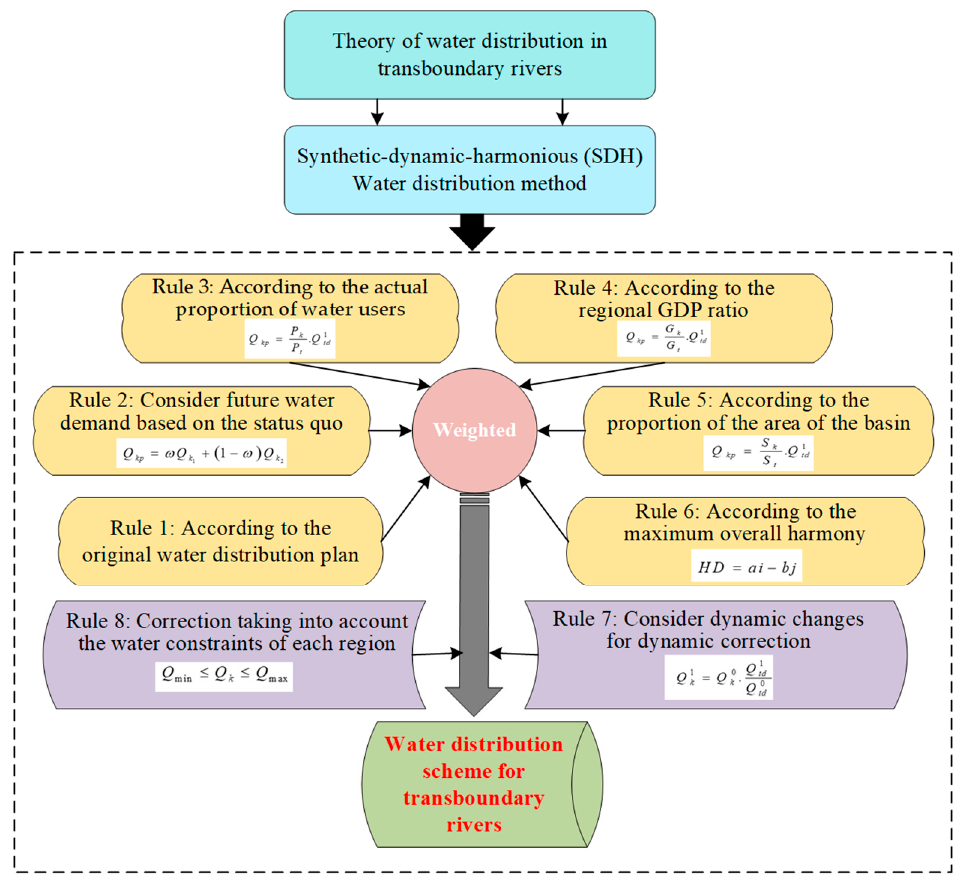
Figure 3. Calculation process of water distribution in transboundary rivers.